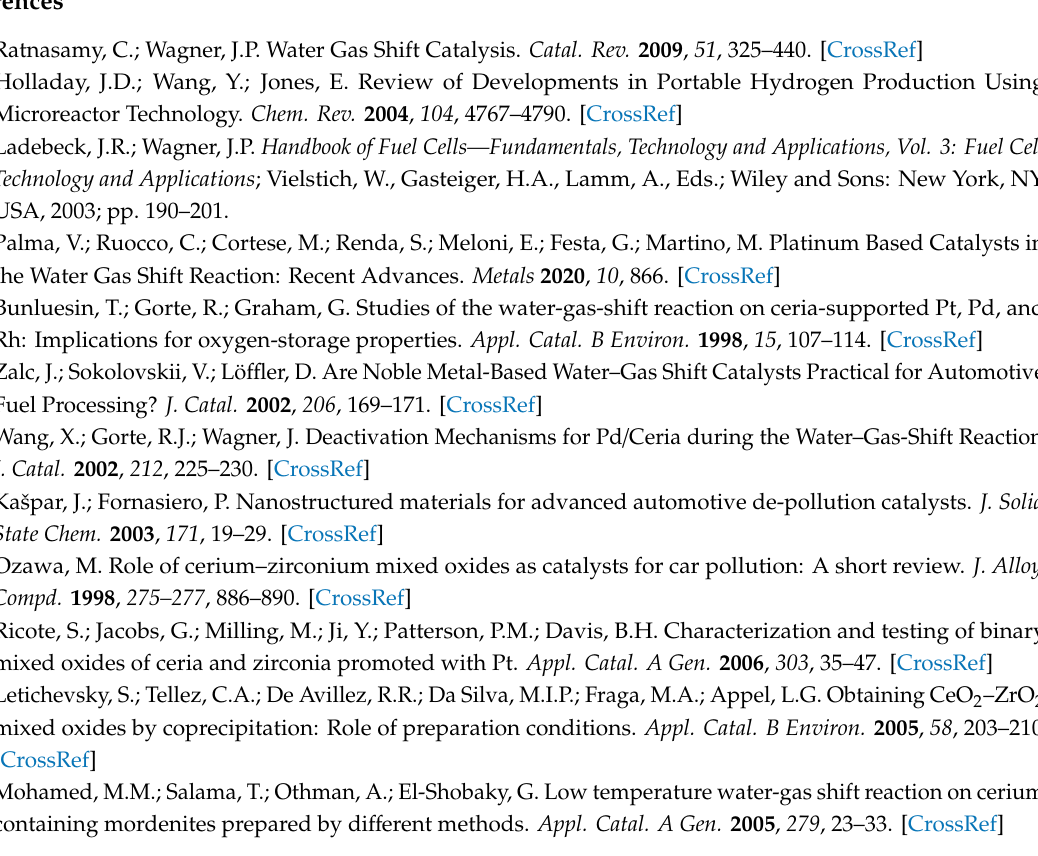
Figure S1: Schematic presentation of the experimental setup used for water-gas activity testing. Figure S2: The principle of particle formation in a flame. Figure S3: The setup for flame spray pyrolysis employed at DTU. Figure S4: The principle of spray drying. Figure S5: The Lab-Plant SD-06 Laboratory spray